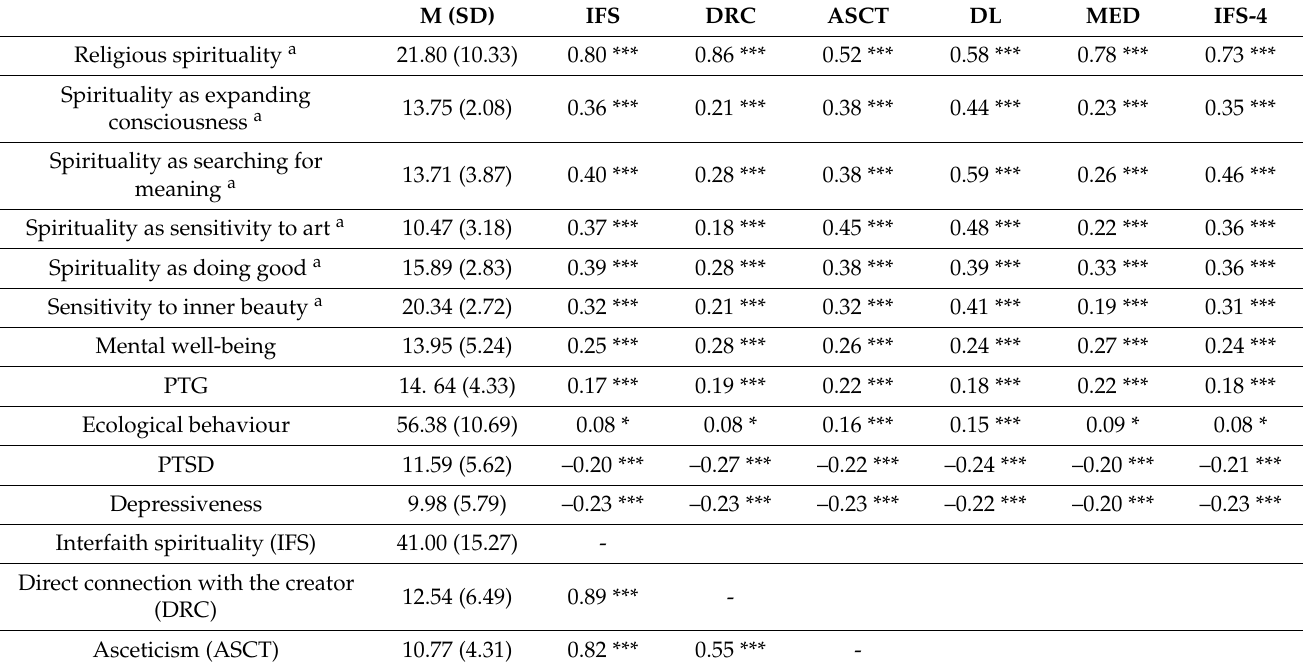
Table 1. Descriptive statistics and